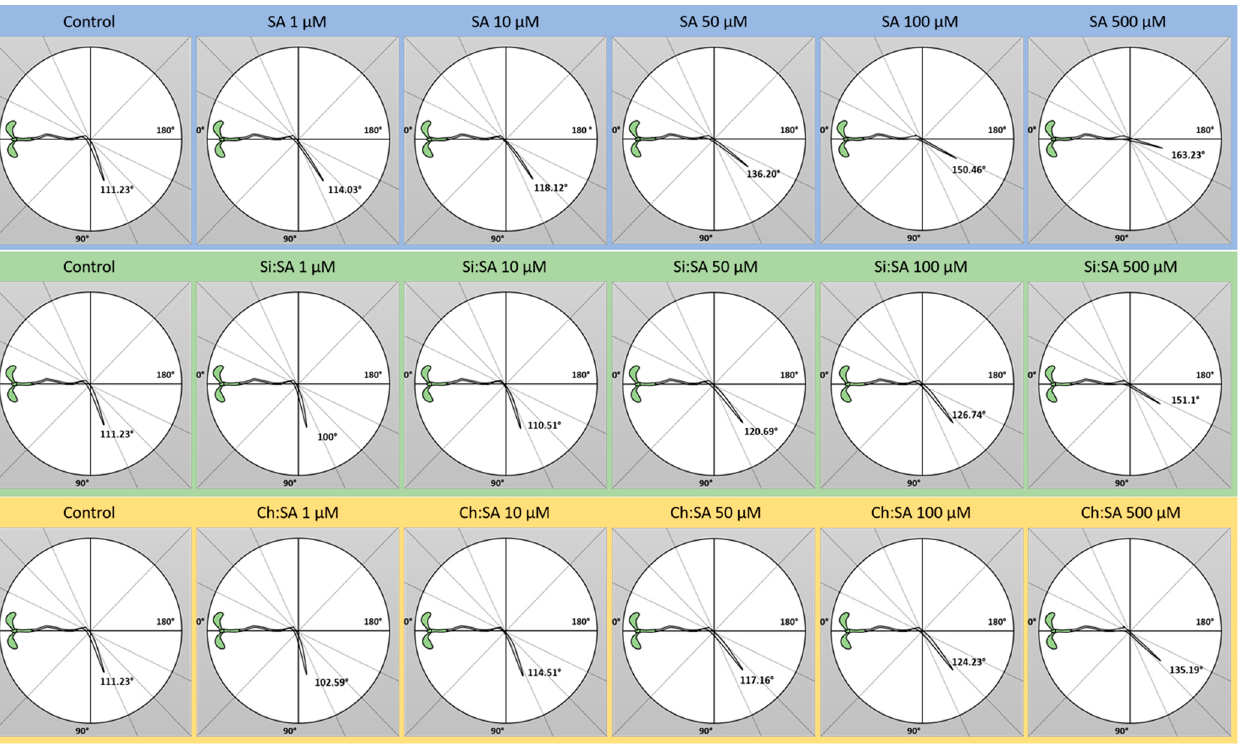
Figure 5. Effect of free SA, Si:SA and Ch:SA on root reorientation in Col-0 Arabidopsis plants. Five- day-old plants were transferred to media containing the different SA treatments and the root angle was measured 8 h later.